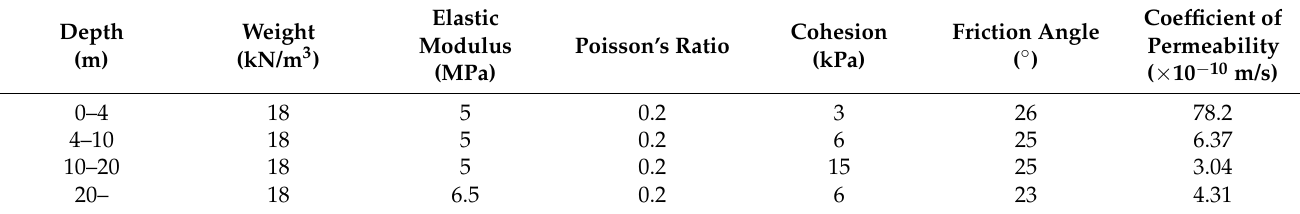
Table 2. The parameters of consolidating